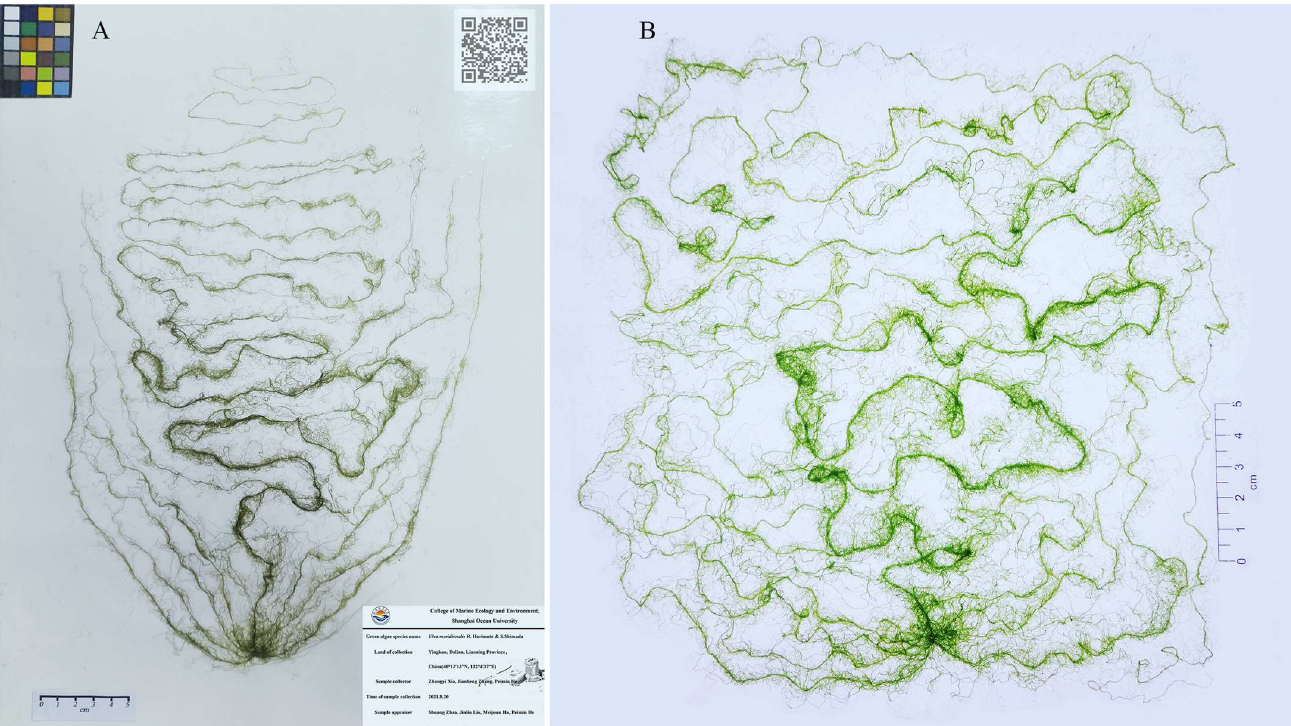
Figure 2. Morphological photography and herbarium documentation: ( A ) specimen of Ulva merid- ionalis (Voucher code: SHOU-GMA-0316), and ( B ) morphology of the thallus under indoor culture conditions.